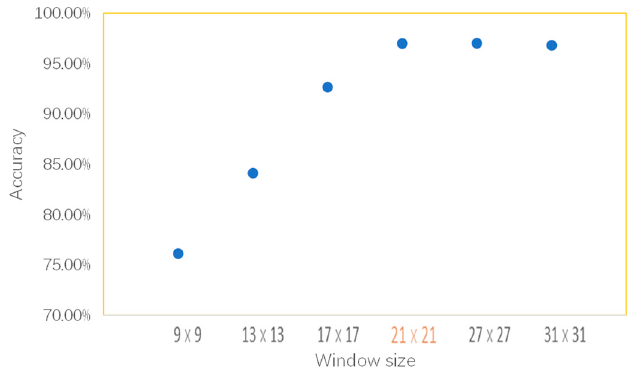
Figure 11. Indian pines dataset OA with window size changes.